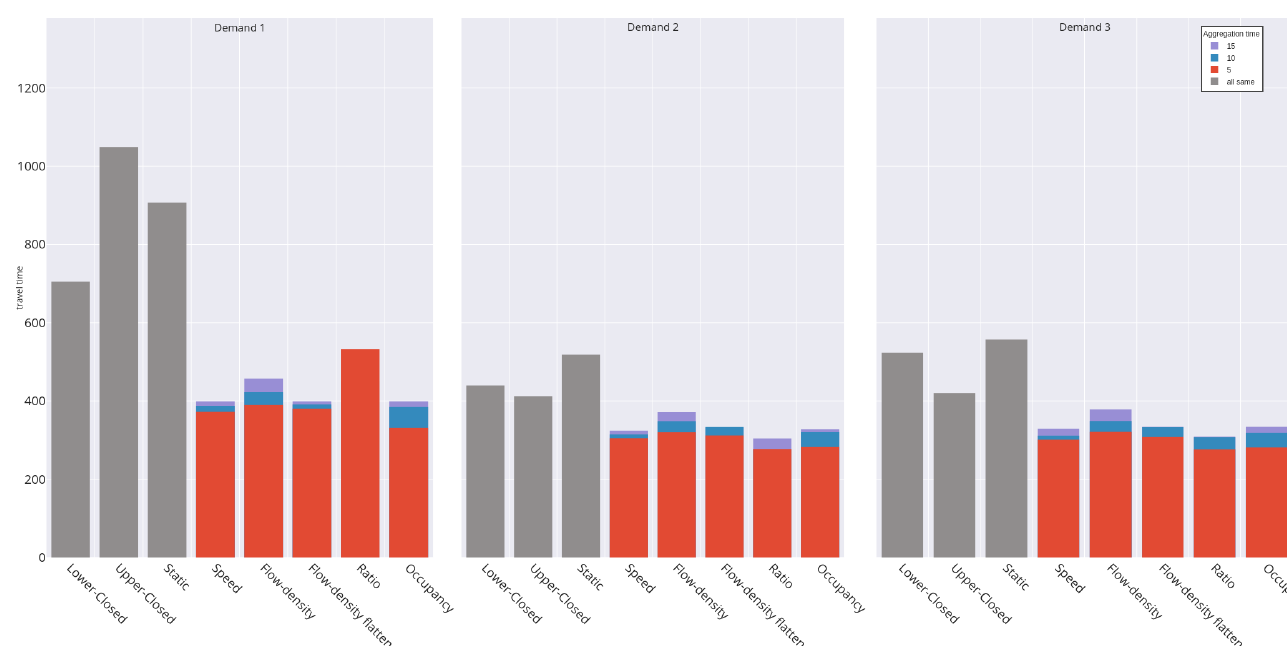
Figure 13. Travel times in seconds for the three demands for the 2-Intersection model. The red bar chart represents the 5 min aggregation time, the blue one represents the 10 min aggregation time, and the purple one represents the 15 min aggregation time. They are placed on top of each other to demonstrate the difference in aggregation times. The grey bars represent the base cases, where no algorithm is applied. Each demand is shown in its own bar chart, allowing them to be